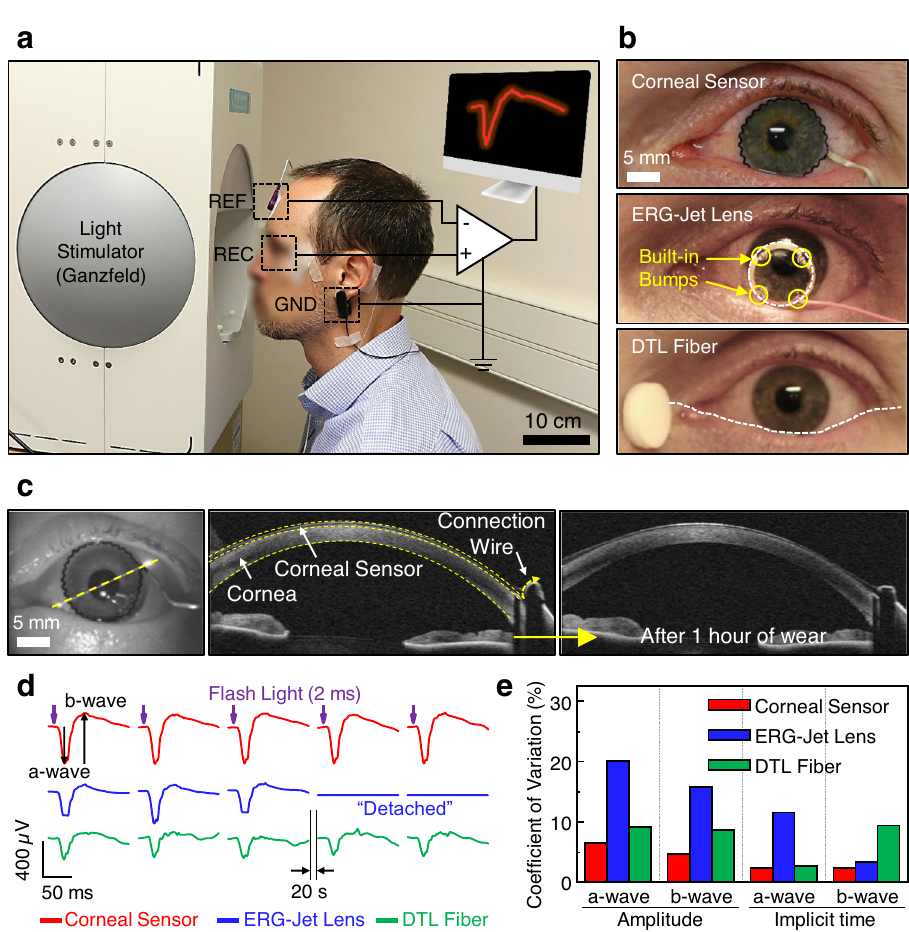
Fig. 4 Real-time ERG recordings in a human eye. a Measurement setting for ERG recordings using a Ganzfeld stimulator in scotopic conditions. b Photographs of the eye worn with the corneal sensor (top panel) by comparisons with the ERG-Jet lens (middle panel) and DTL fi ber (bottom panel). The yellow circles denote the four built-in bumps of the ERG-Jet lens. The white dotted line denotes the outer trace of the DTL fi ber. c Photograph (left inset) and the corresponding anterior segment ocular coherence tomography (AS-OCT) images of the corneal sensor worn on the cornea upon insertion (middle inset) and after 1 h of the wear (right inset). d Full- fi eld ERG signals acquired from the three different devices under the light intensity of 10.0 cd·s m − 2 . e Coef fi cient of variation (CV) of the amplitudes and implicit times of the a and b waves extracted. The number of recordings with each device was ten (corneal sensor), eight (ERG-Jet lens), and nine (DTL fi ber) recordings,